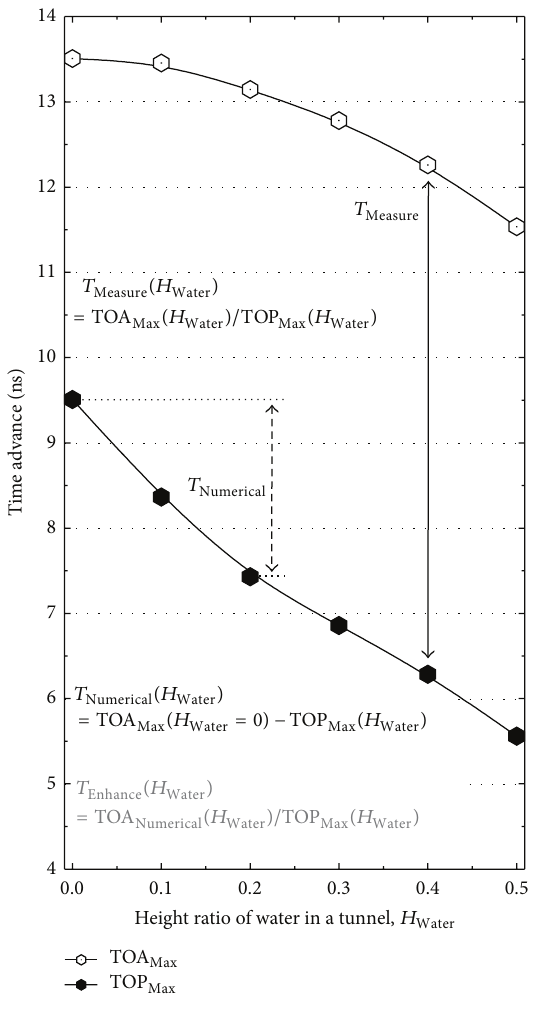
Figure7:Twomaximumtimeadvancescorrespondingtothefastest TOP (TOP Max ) and the fastest TOA (TOA Max ) for 6 different height ratios of water inside the tunnel ( 𝐻